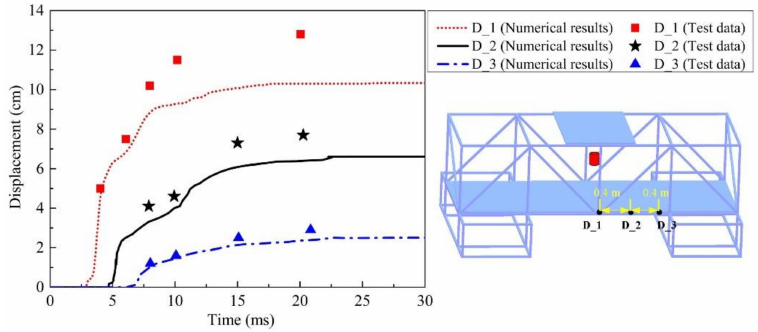
Figure 18. Comparison of numerical and test data of gauge points in tube.